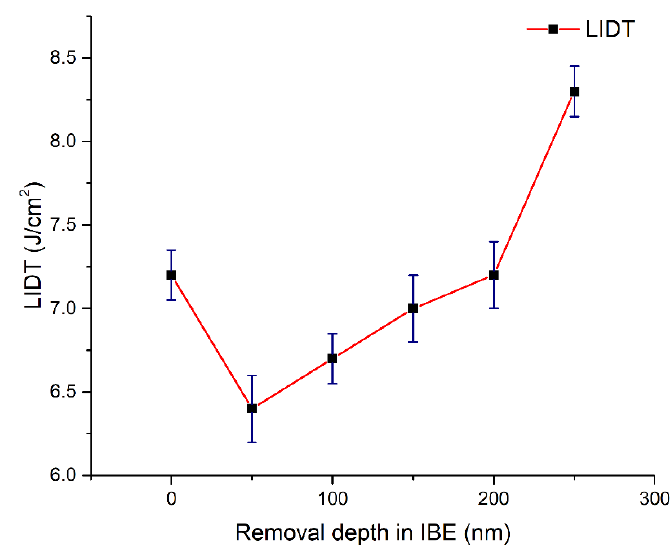
Figure 6. Laser-induced damage threshold (LIDT) evolution at various IBE depths.